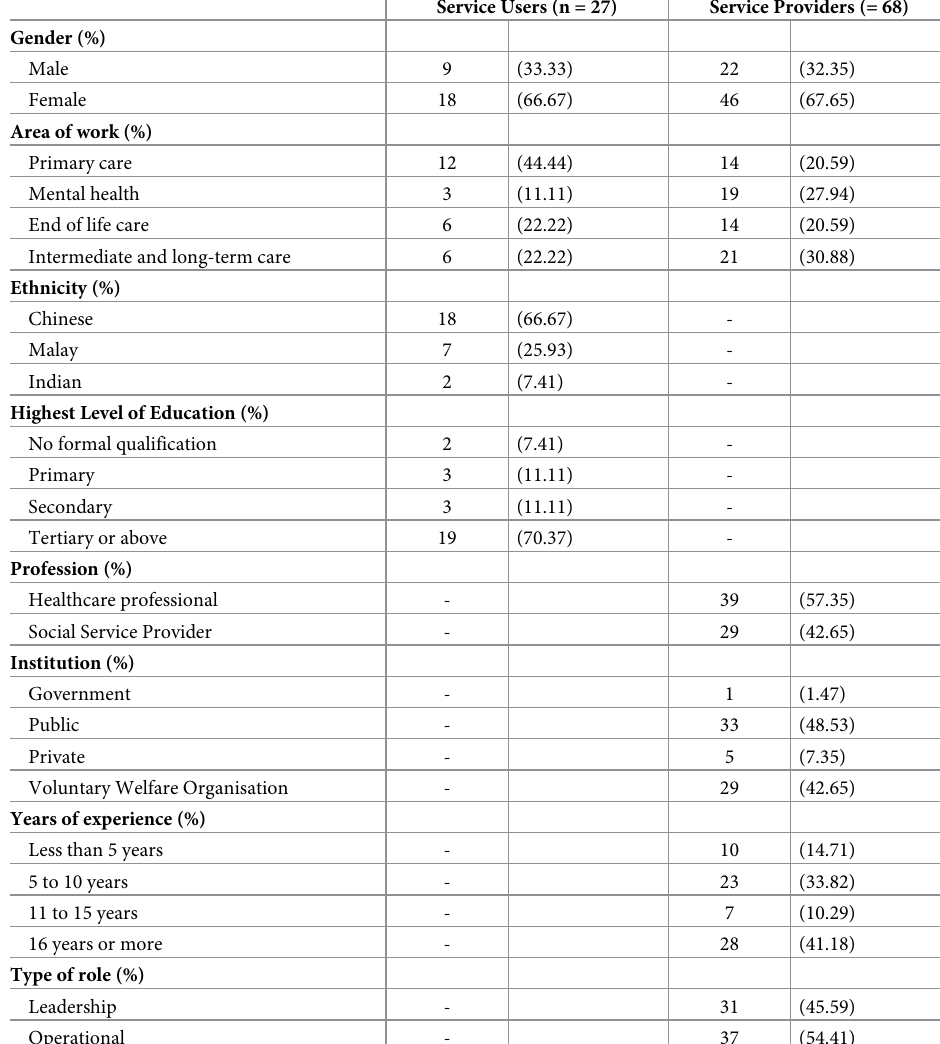
Table 2. Phase 3—characteristics of service users and service providers in in-depth interviews (n =